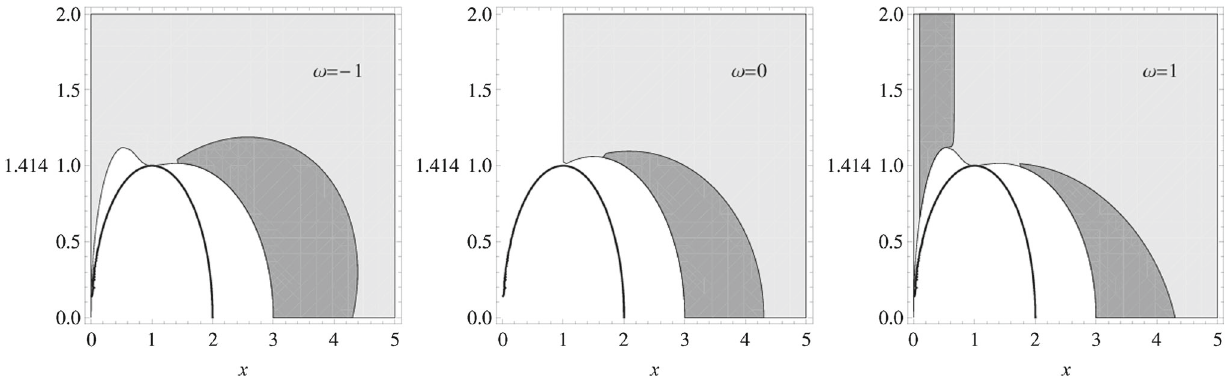
Fig. 7 Local extrema position x and type (maxima/minima) of the effective potential V eff ( r ,θ = π/ 2 ) for different values of RN charge parameter Q and for all three considered values of ω parameter. Thick black line corresponds to event horizon and restrict the dynamical region. Darker grey colour denotes region where maxima of the V eff